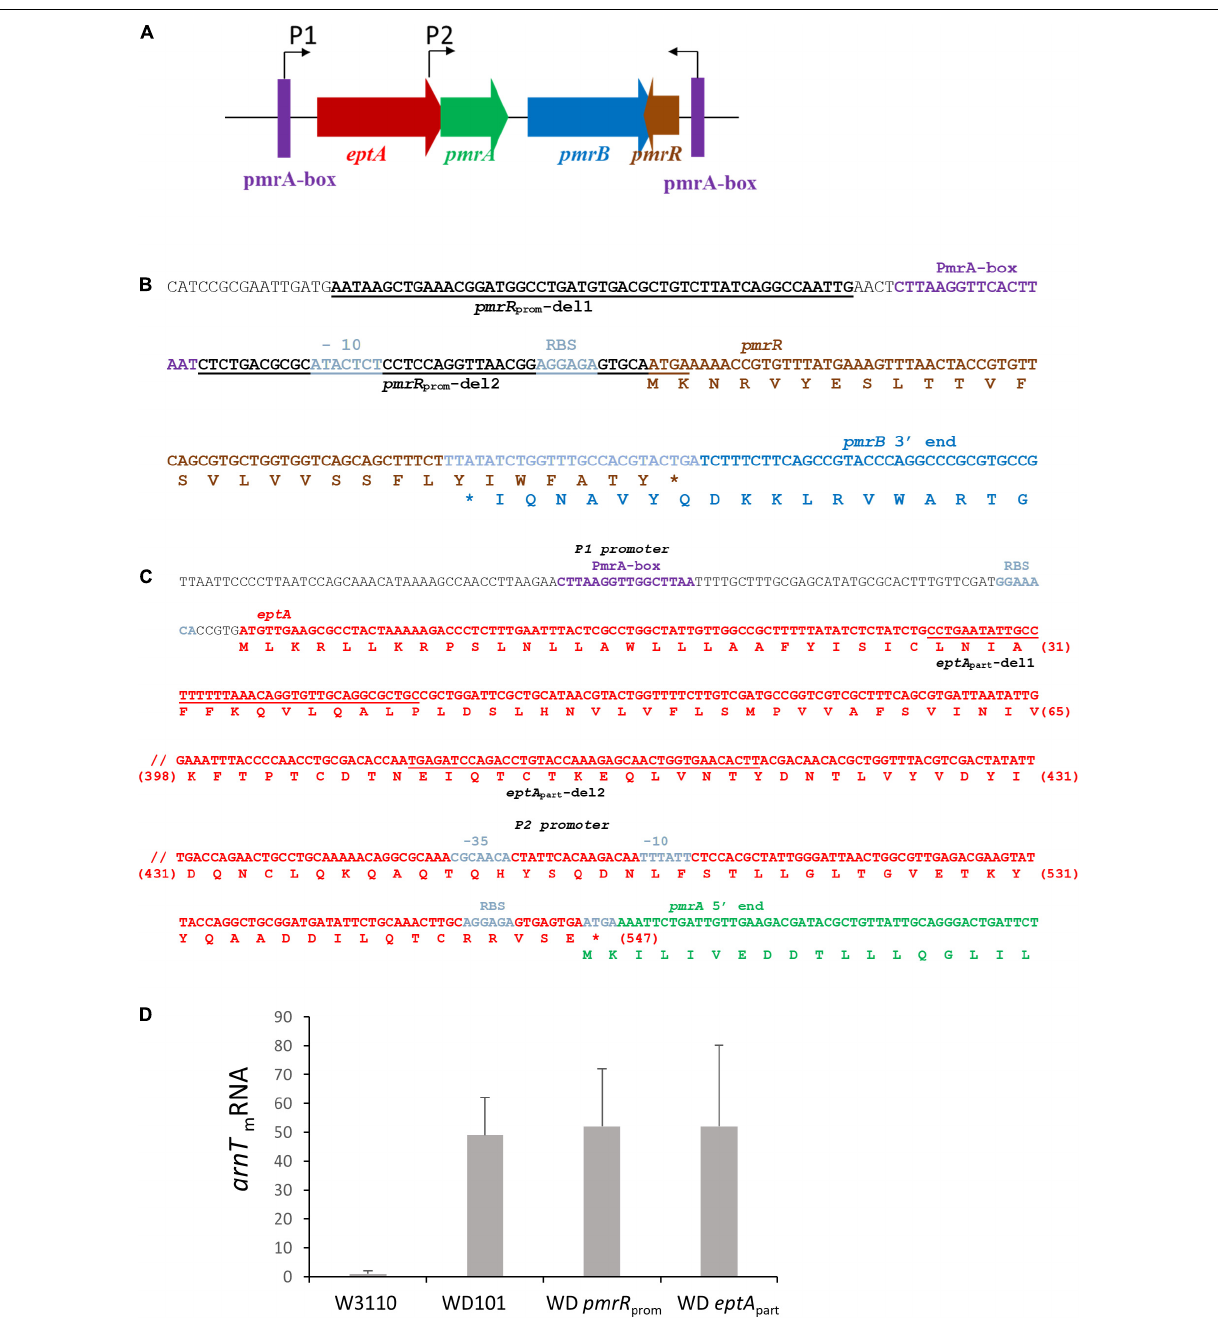
Frontiers in Microbiology |